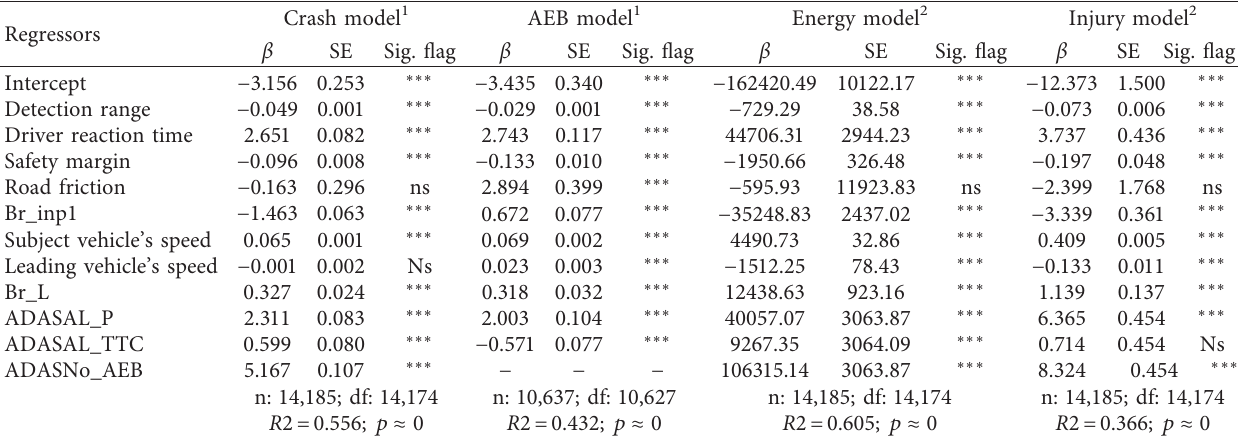
Table 7: Regression analysis results: (a) crash model, (b) AEB model, (c) energy model, and (d) injury